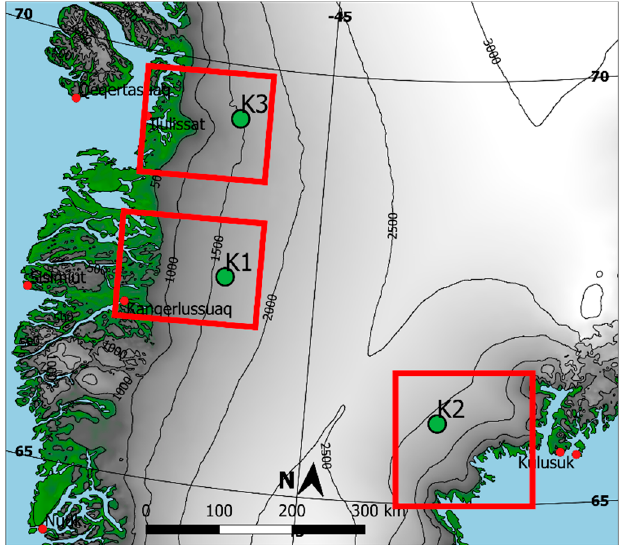
Figure 2. Map of Greenland with topography (isolines every 500 m). The red boxes mark the areas of the KABEG experiment: K1 near Kangerlussuaq, K2 near Kulusuk, and K3 near Ilulissat. The green dots are the positions for the comparisons of vertical profiles.